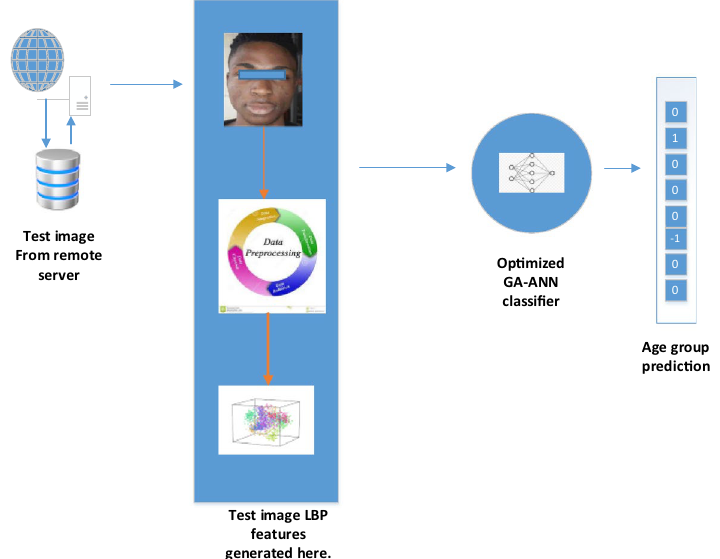
Figure 11. GA-ANN AES testing